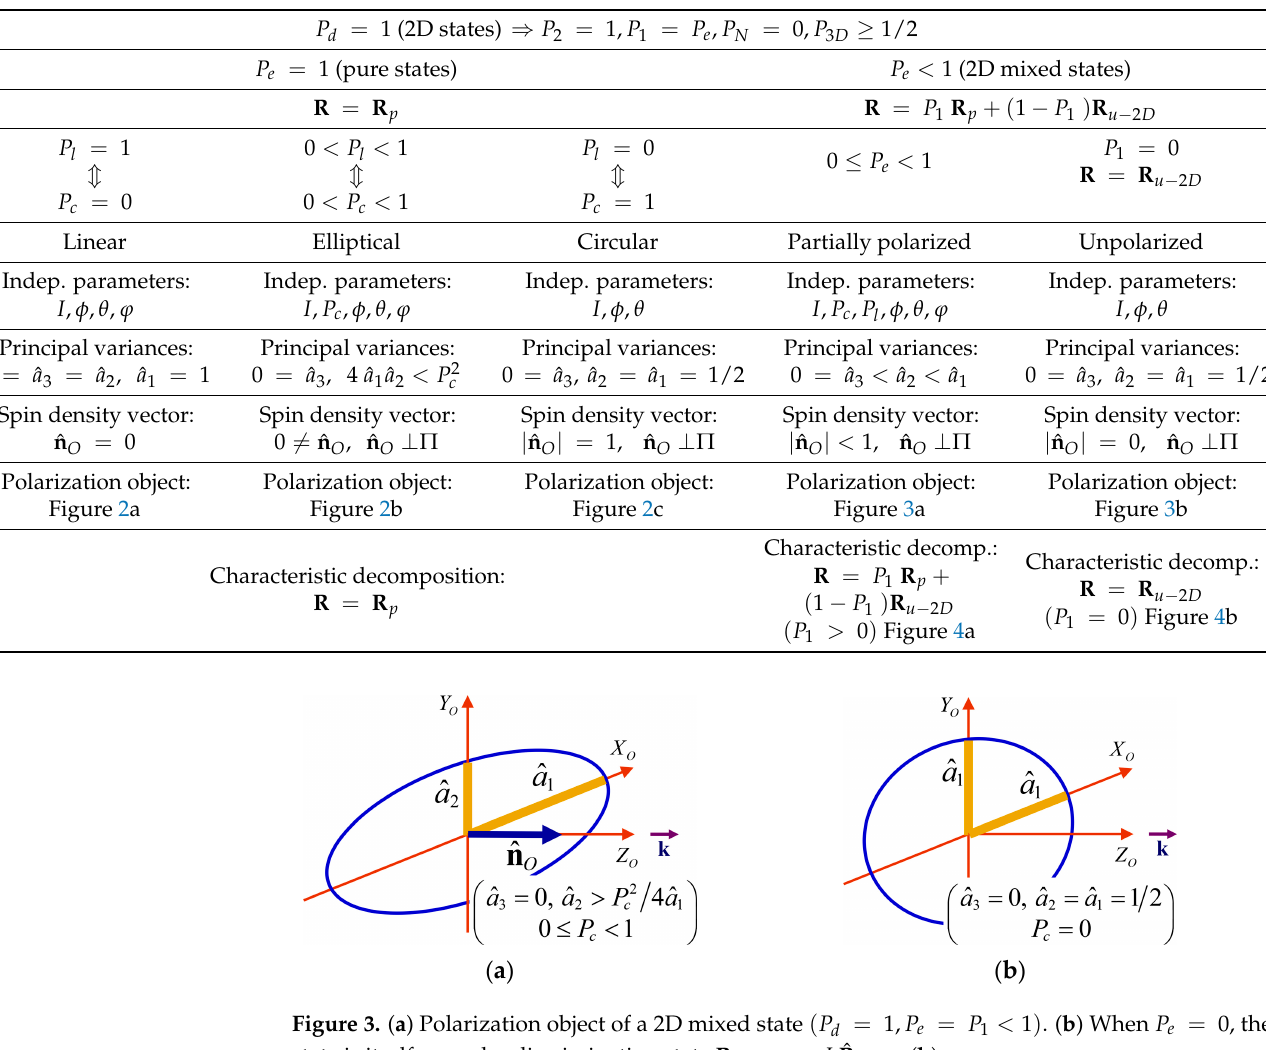
Figure 3. ( a ) Polarization object of a 2D mixed state ( P d = 1, P e = P 1 < 1 ) . ( b ) When P e = 0, the